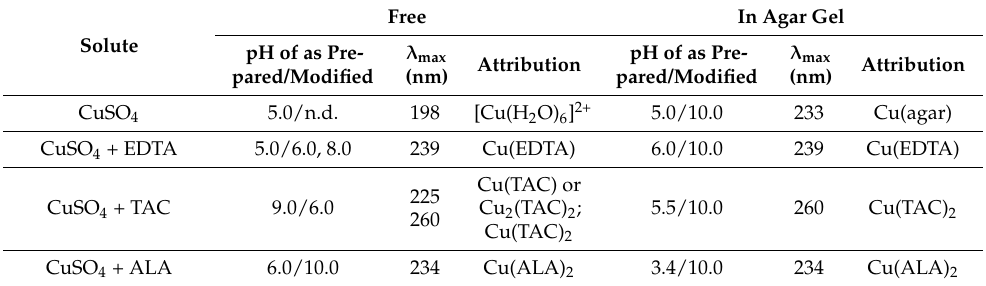
Table 1. pH values and spectral position of the metal-ligand charge transfer (MLCT) bands for precur- sors and complexes of Cu(II) with ethylenediaminetetraacetic acid (EDTA), ammonium citrate tribasic (TAC), and alanine (ALA), in aqueous solutions, free, and in agar gels, with relative attributions. Free In Agar Gel Solute λ max λ max pH of as Pre- pH of as Pre- Attribution Attribution pared/Modified pared/Modified (nm) (nm) CuSO 4 5.0/n.d. 198 [Cu(H 2 O) 6 ] 2+ 5.0/10.0 233 Cu(agar) CuSO 4 + EDTA 5.0/6.0, 8.0 239 Cu(EDTA) 6.0/10.0 239 Cu(EDTA) Cu(TAC) or 225 Cu 2 (TAC) 2 ; 5.5/10.0 260 Cu(TAC) 2 CuSO 4 + TAC 9.0/6.0 260 Cu(TAC) 2 CuSO 4 + ALA 6.0/10.0 234 Cu(ALA) 2 3.4/10.0 234 Cu(ALA)